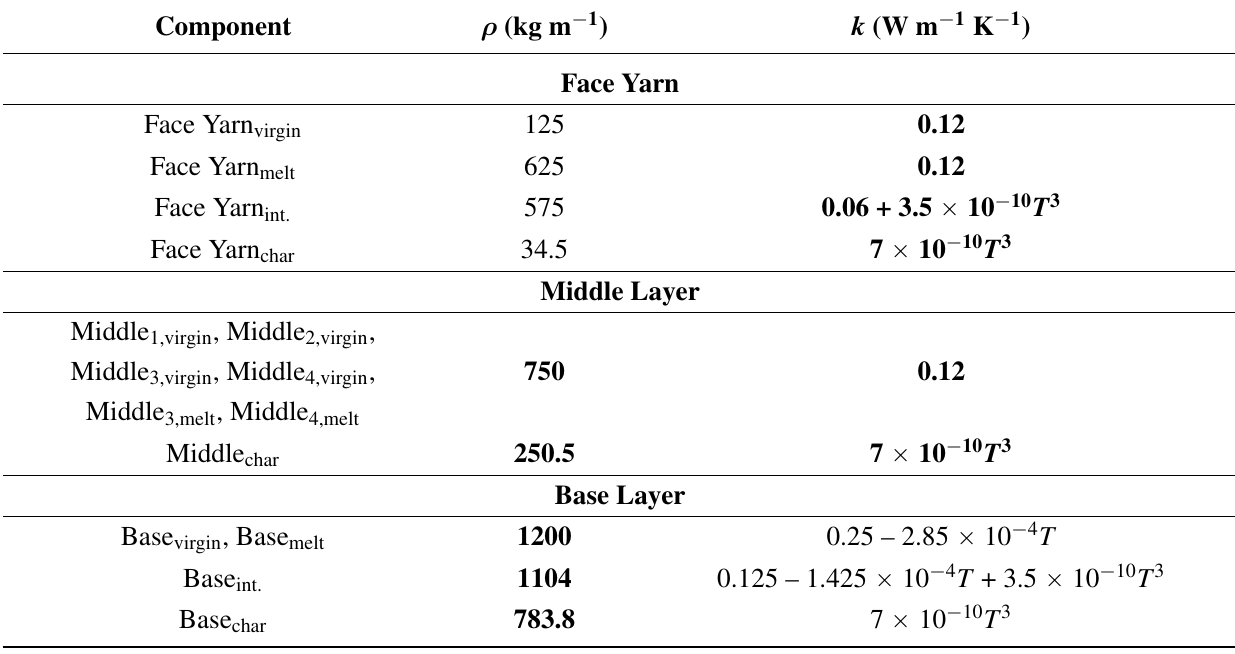
Table 6. Thermal conductivity and density values for Final Full Carpet model. Modifications to property values from individual layer models are shown in